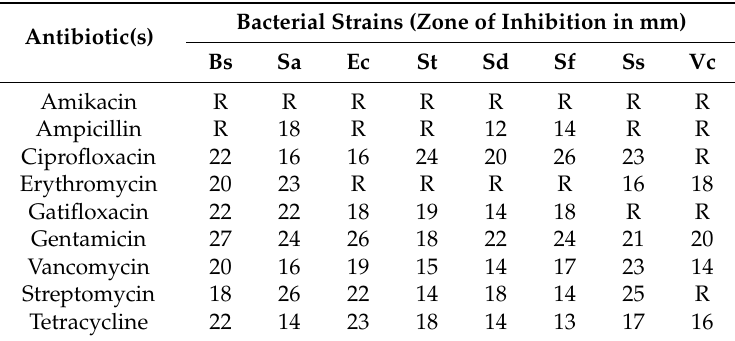
Table 5. Antibiogram among the test bacterial